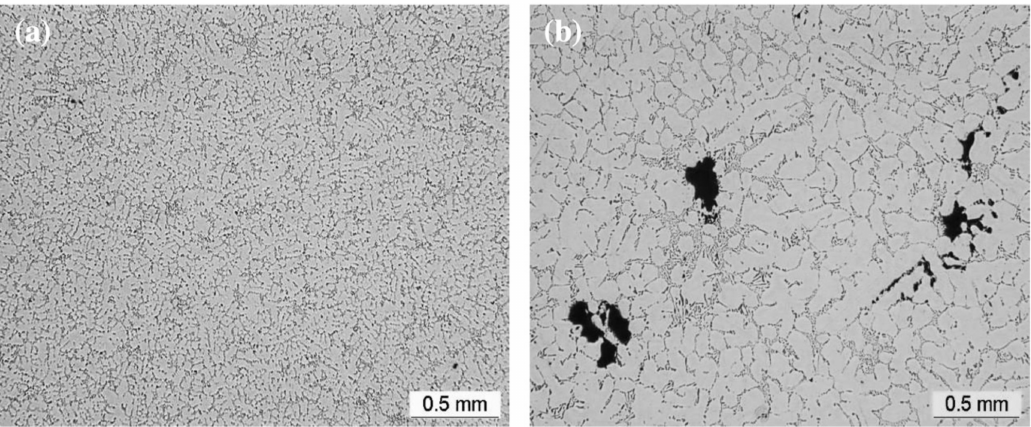
Figure 4. A356-T7 alloy microstructure for die casting ( a ) and lost foam casting ( b